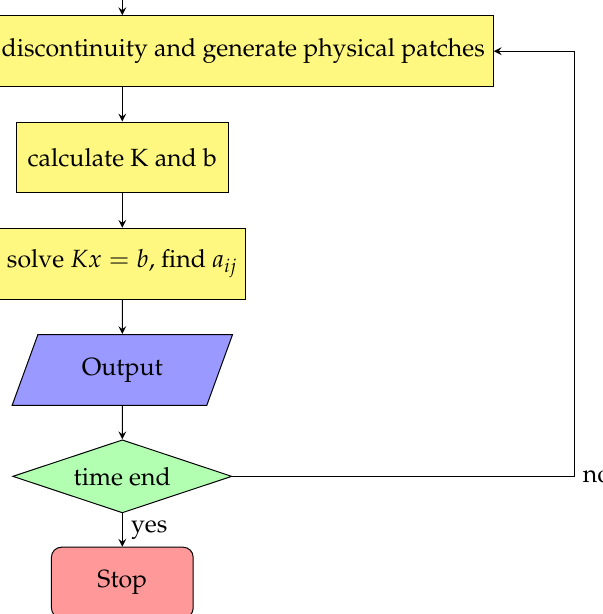
Figure 3. Algorithm flow chart and calculation